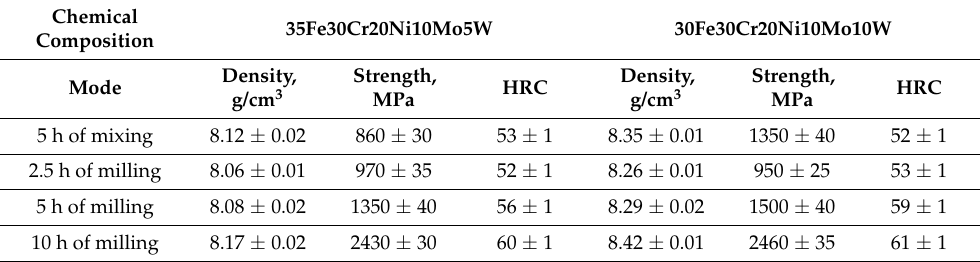
Table 1. Physical and mechanical properties of bulks produced during pressure-assisted sintering